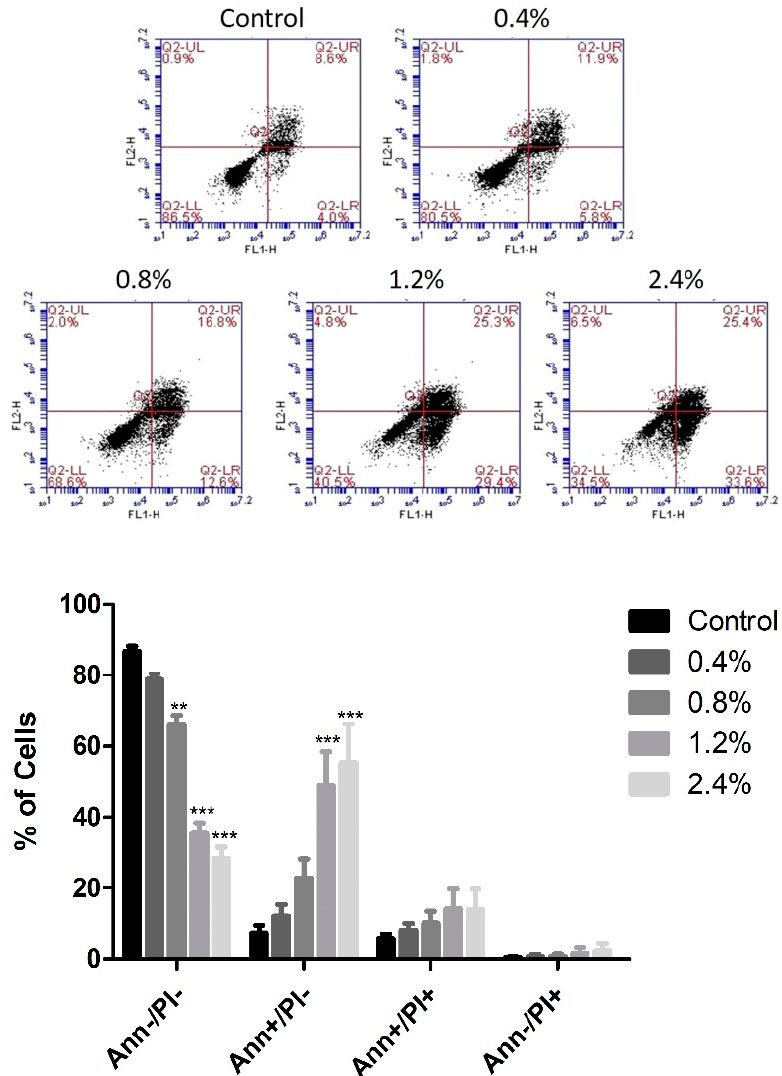
Figure 6. E ff ect of UD extract on apoptosis after 72 h. U937 cells were treated with di ff erent concentrations of UD extract at 0.4, 0.8, 1.2, and 2.4%. The cells were stained with annexin / PI after 72 h, and then analyzed using flow cytometry. The x-axis represents annexin V and the y-axis represents PI. Lower left quadrant represents Ann − / PI − cells, lower right quadrant represents Ann +/ PI − cells, upper left quadrant represents Ann − / PI + cells, and upper right quadrant represents Ann +/ PI + cells. The histogram represents the means from three independent experiments +/ − SEM. ** and *** indicate p < 0.001 and p < 0.0001, respectively, compared to the control group. For further confirmation of the increase in apoptosis induced by aqueous UD extract, DNA fragmentation, which is considered a hallmark of apoptosis, was assessed using cell-death ELISA. A significant dose-dependent increase in the enrichment factor was detected in U937 cells after 48 and 72 h of treatment with UD extract. A significant 2.5-fold increase in the enrichment factor was observed in U937 cells at 2.4% UD after 48 h, compared to a more prominent significant increase of almost 3-fold at the same concentration after 72 h (Figure